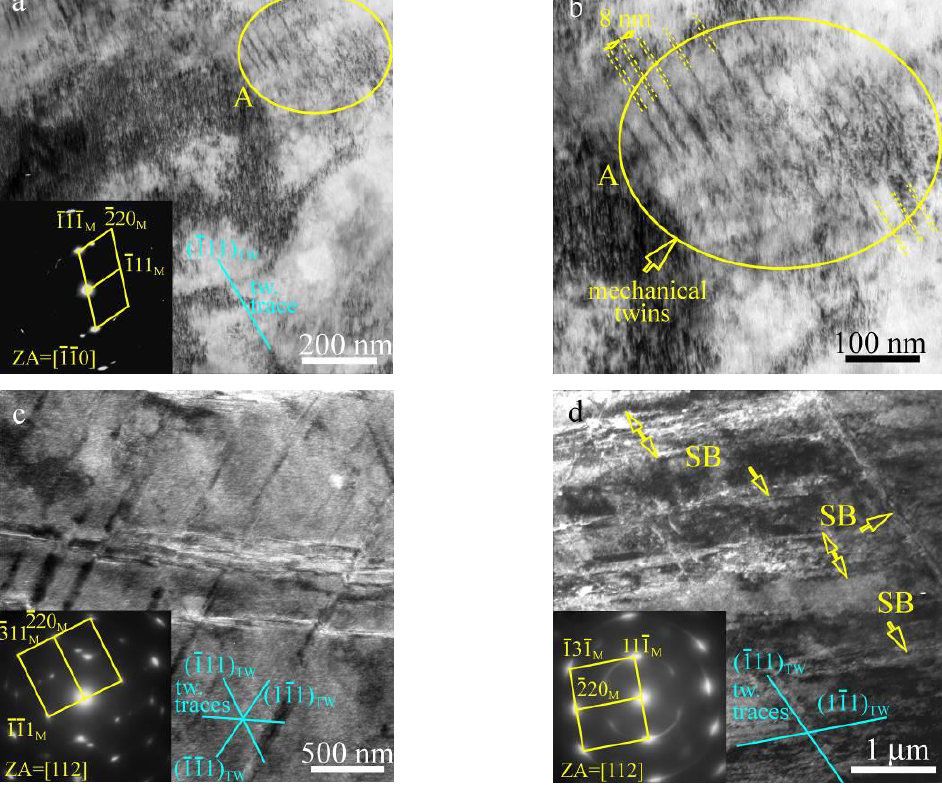
Figure 3. Typical TEM bright-field images of the microstructure and SAED patterns with interpretations (inserts in ( a ), ( c ), and ( d )) in HPT 400 -processed specimens: ( a , b ) — N = 1, ( c ) — N = 2, ( d ) — N = 3. SB — shear band, ZA — zone axis. Image ( b ) is a magnified area in image ( a ) which show thin mechanical twins.